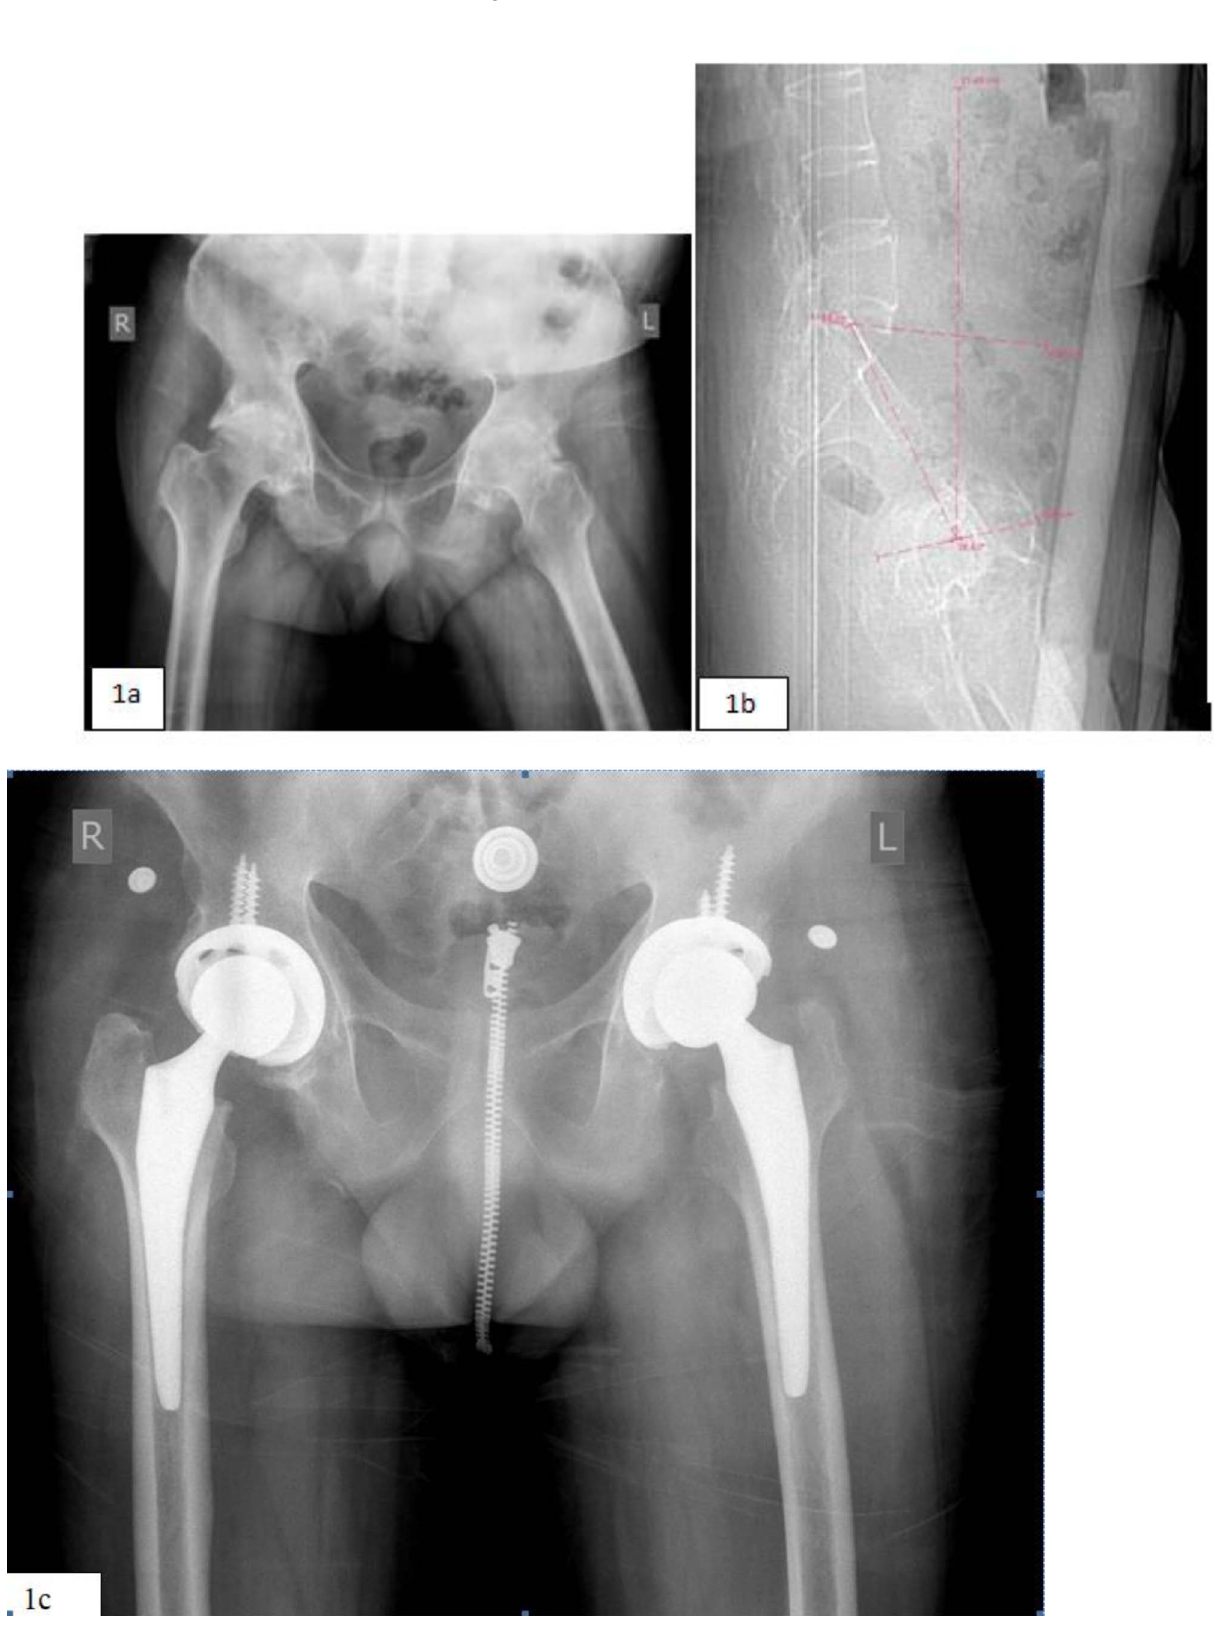
Figure 1. Case 1. (a) Preoperative antero-posterior (AP) views of bilaterally fused hips. (b) Pelvic hyperextension calculation. (c) Six months postoperative antero-posterior (AP) view of the